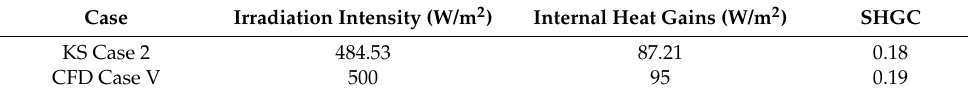
Table 9. A validation study on Computational Fluid Dynamics (CFD) Case